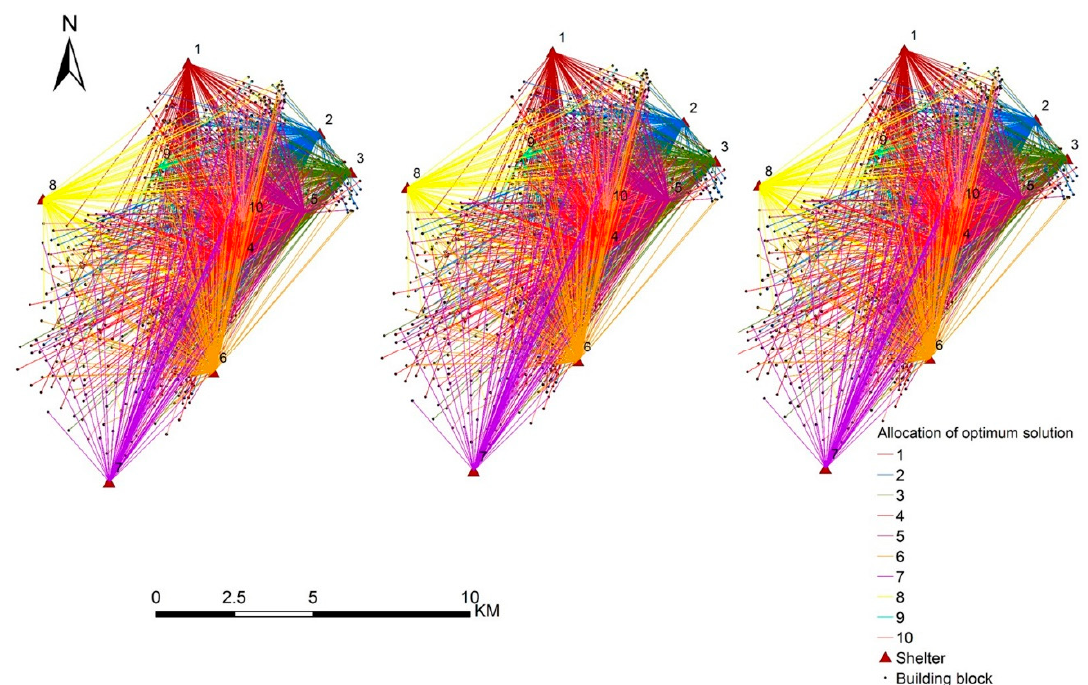
Figure 11. The allocation map of optimum solutions A ( left ), B ( center ), and C ( right ).